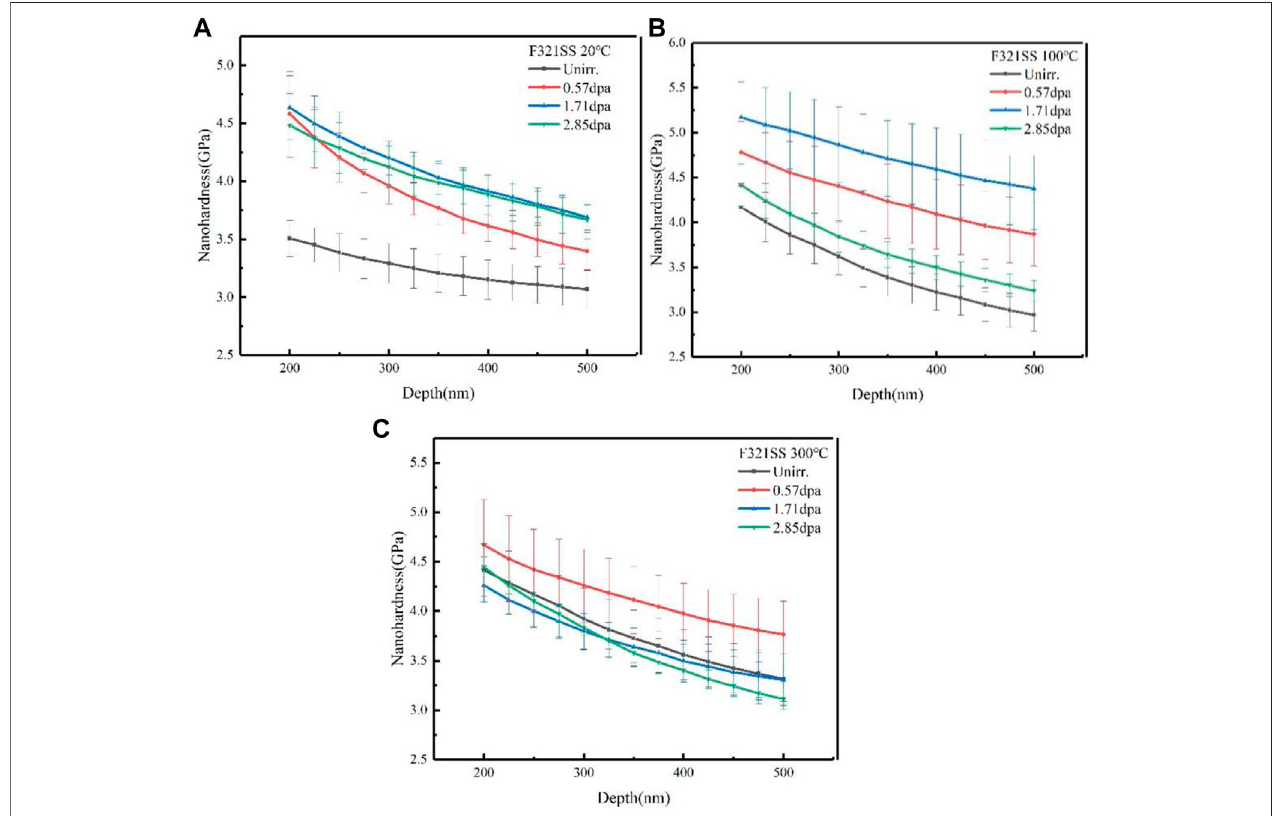
FIGURE 4 | Average nanohardness versus the indentation depth of F321 austenitic stainless steel that was irradiated at (A) 20 ° C (B) 100 ° C, and (C) 300 ° C.